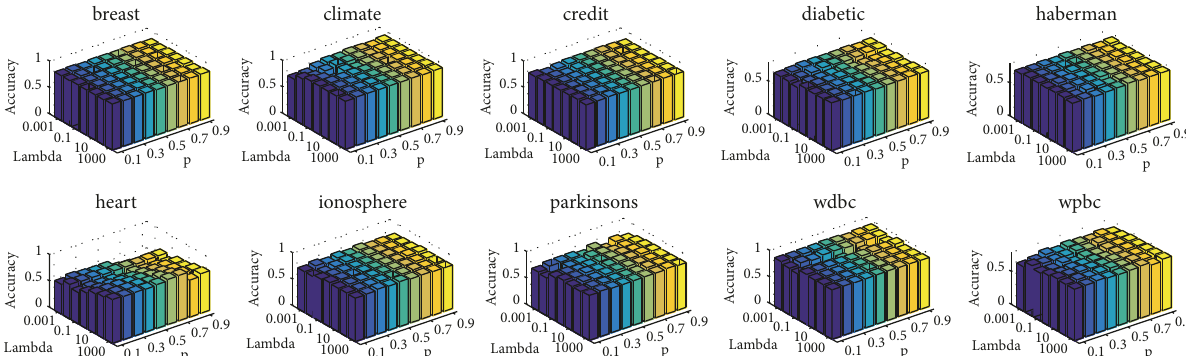
Figure 6: The results of our model base different parameters.